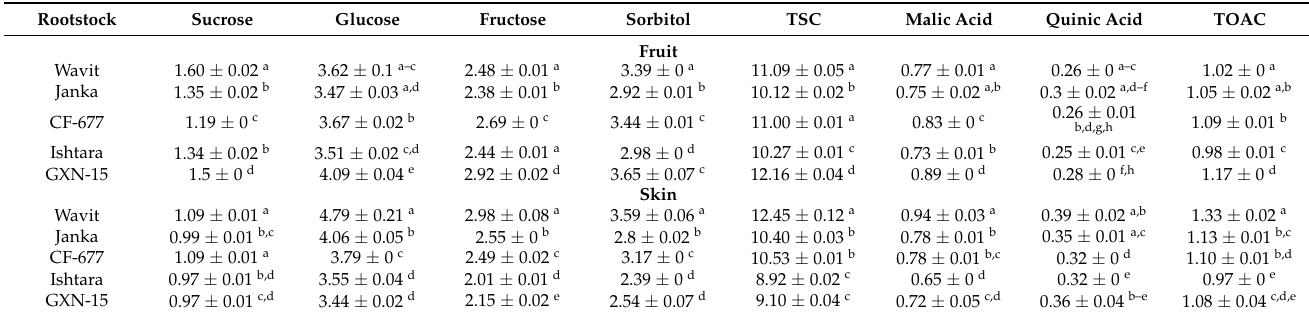
Table 1. Sugars and organic acids quantified in the fruit and fruit skins of plums growing on different rootstocks by using 1 H